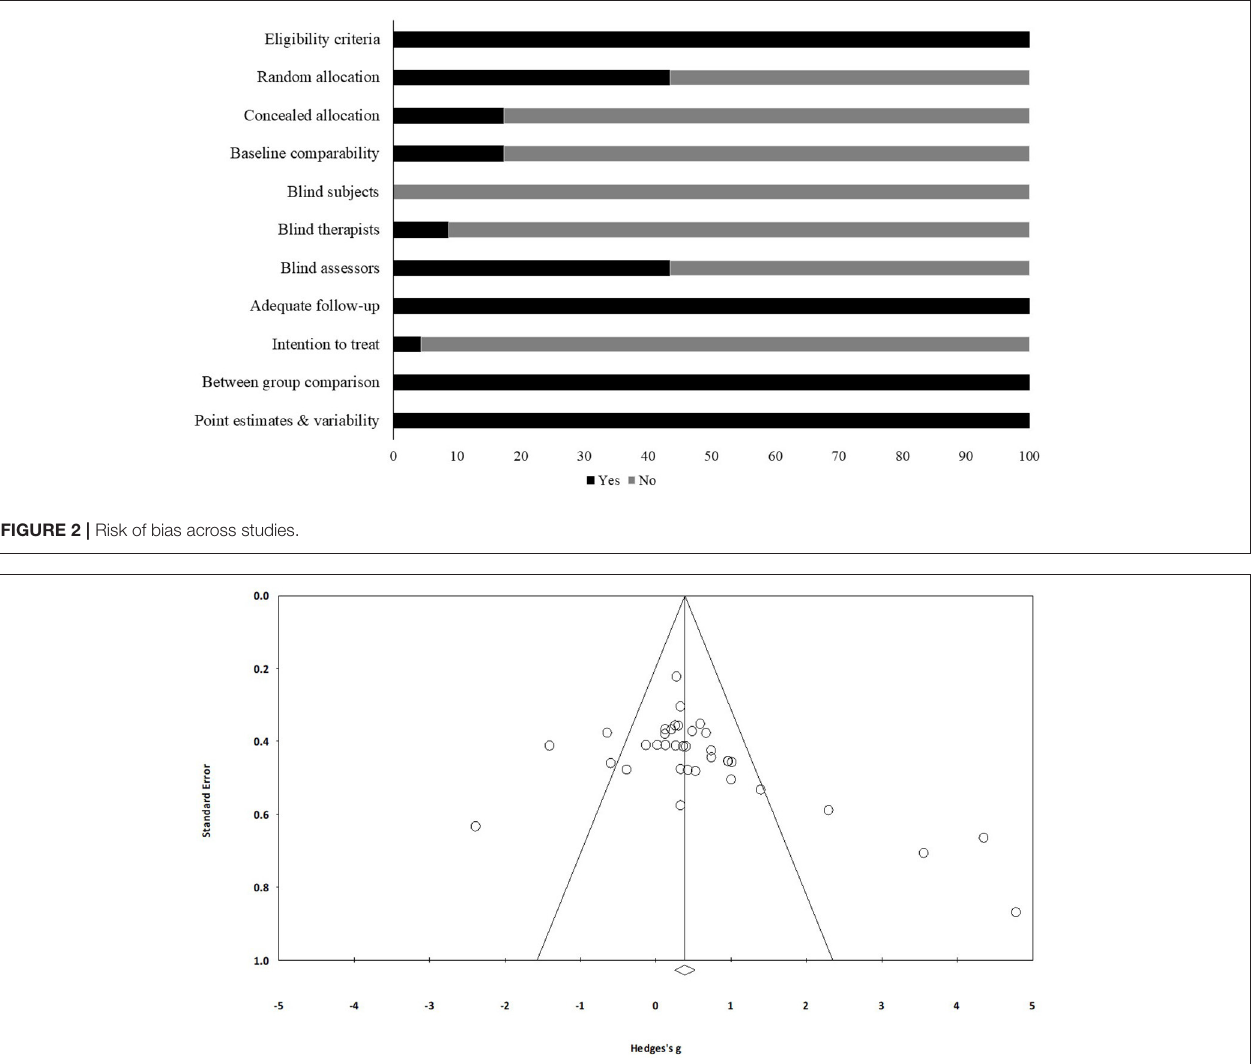
Frontiers in Neurology |